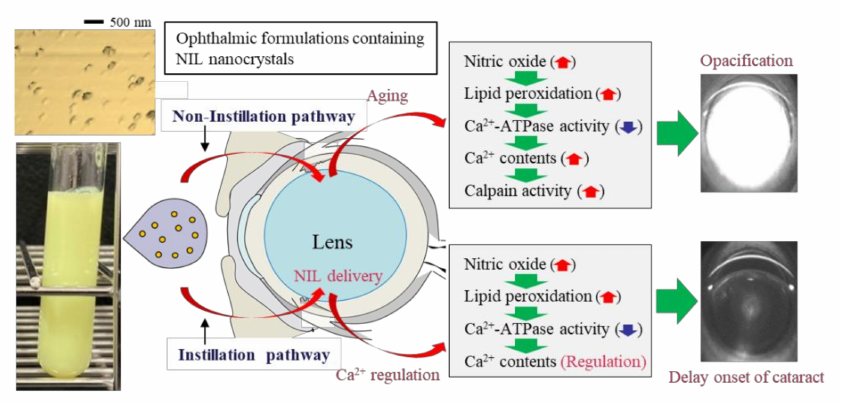
Figure 9. Scheme for the anti-cataract effect following the instillation of NIL-NP dispersions in